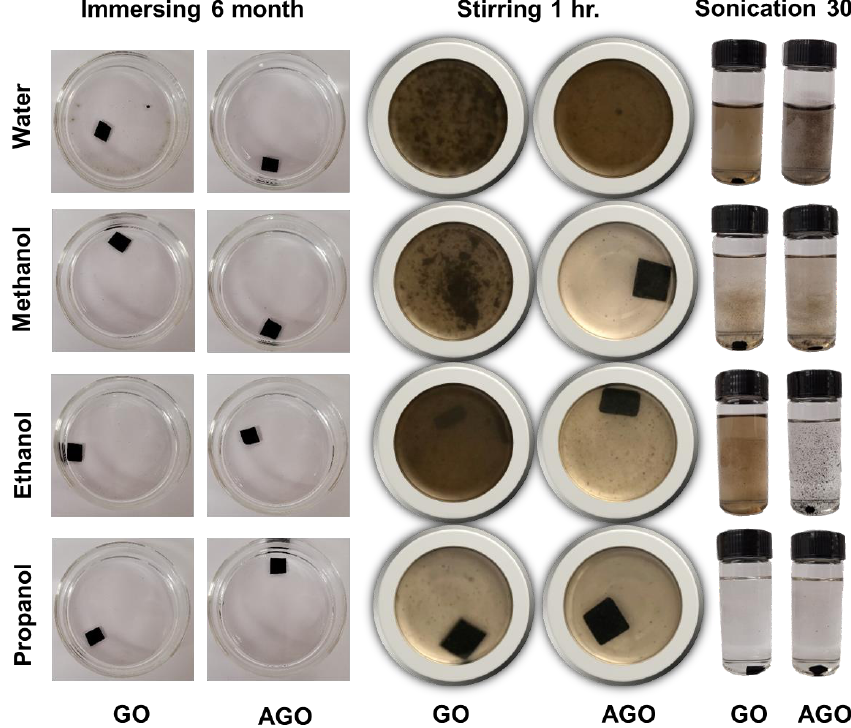
Figure 3. Stability of the GO and AGO membranes in water, methanol, ethanol, and propanol. The GO and AGO membranes were soaked ( left ), vigorously stirred ( middle ), and sonicated ( right ) in different polar solvents for different time intervals.